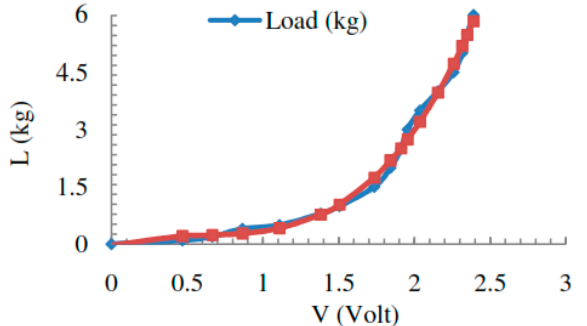
Figure 1. Relationship between voltage (V) and load (kg) of FSR 402 sensor.